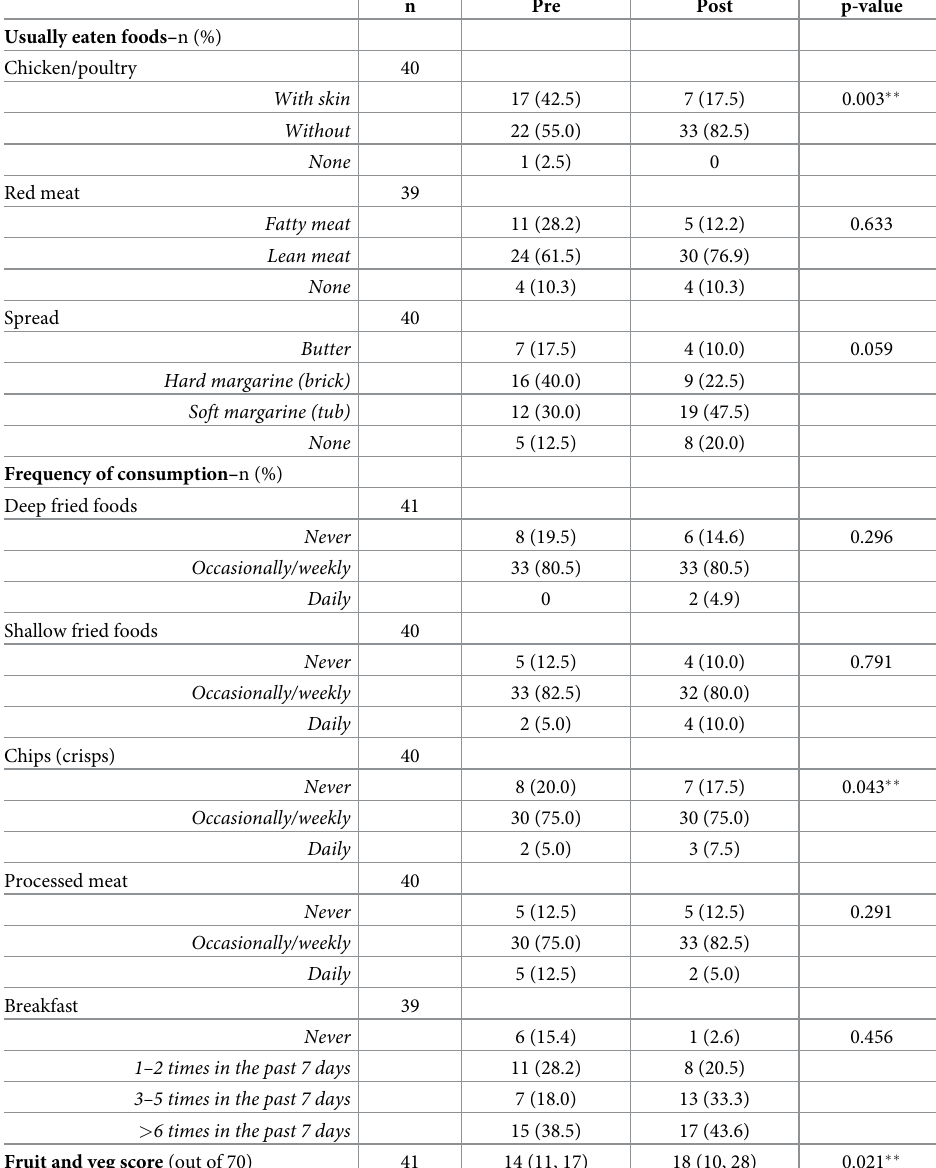
> 6 times in the past 7 days 17 (43.6) Fruit and veg score (out of 70) 41 14 (11, 17) 18 (10, 28) 0.021 �� � Data presented as n (%) where indicated; and median (IQR) for data that are not-normally distributed. Chi2 analysis used for categorical data, Wilcoxon sign-rank test used for not-normally distributed data. P values shown for differences between pre and post-programme measurements.